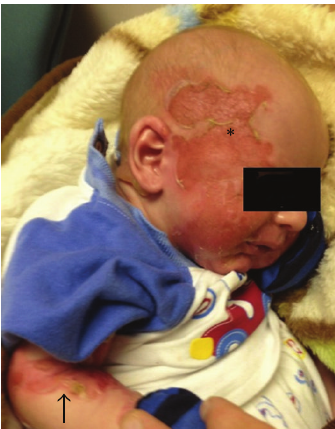
Figure 2: The newborn with widespread facial (asterisk) and forearm skin blistering